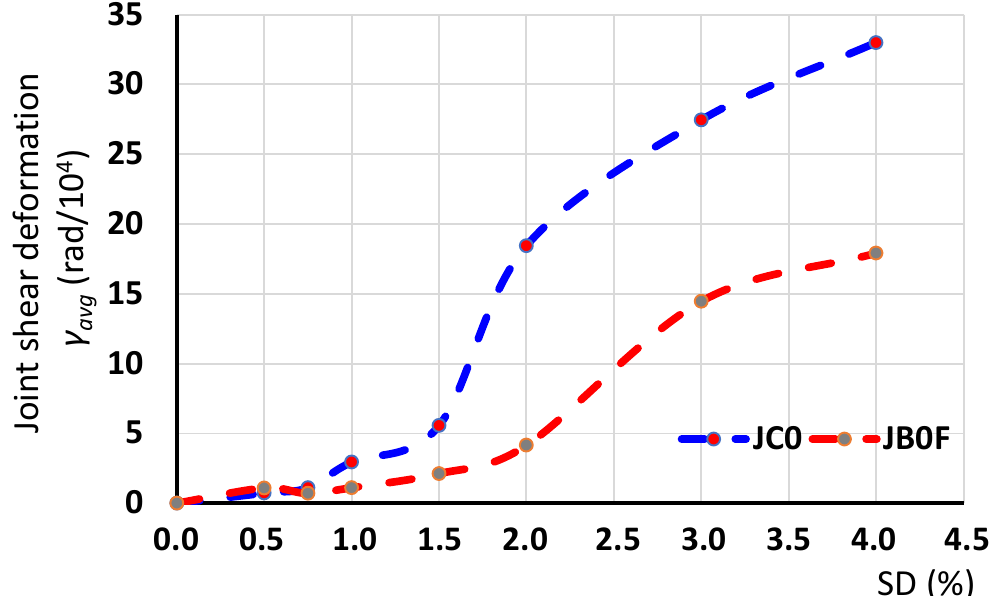
Figure 10. Shear deformations of the joint of the tested subassemblages JC0 and JB0F. Specimen JC0 exhibited higher values of shear deformation than specimen JB0F. This was more conspicuous at higher SDs (> 2%) and it was attributed to the favorable influence of the diagonally applied C-FRP ropes.